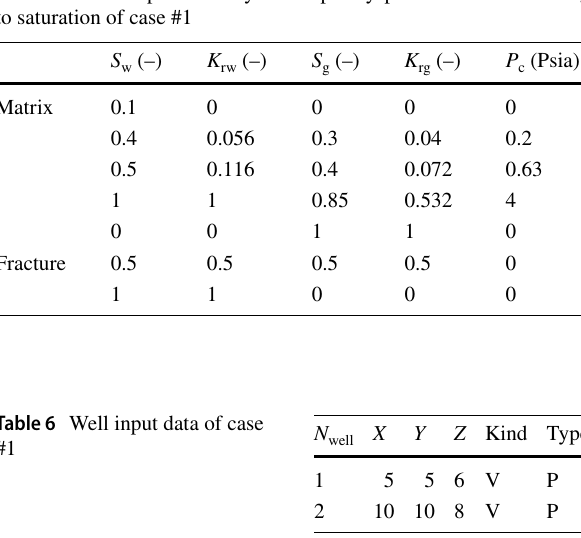
Table 5 Relative permeability and capillary pressure data according